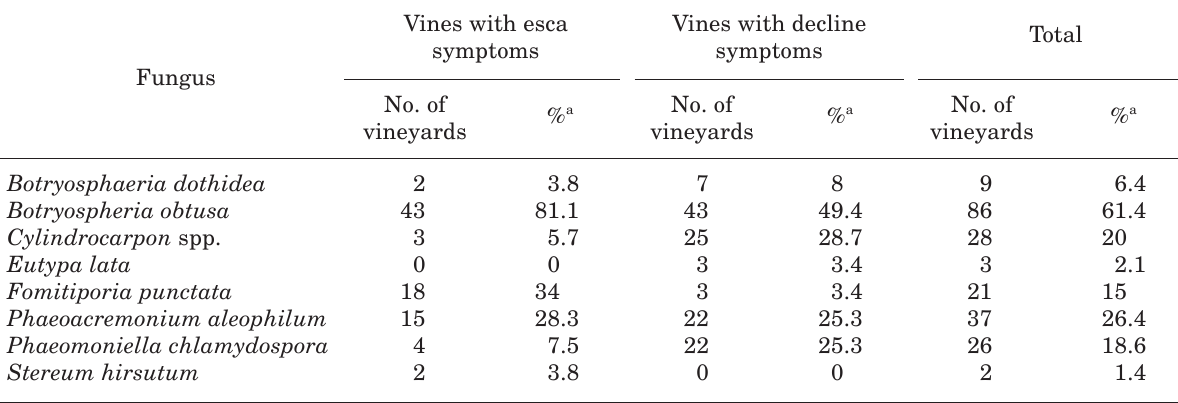
Table 1. Isolation of fungi from sampled vineyards from 1999 to 2001. Fungus